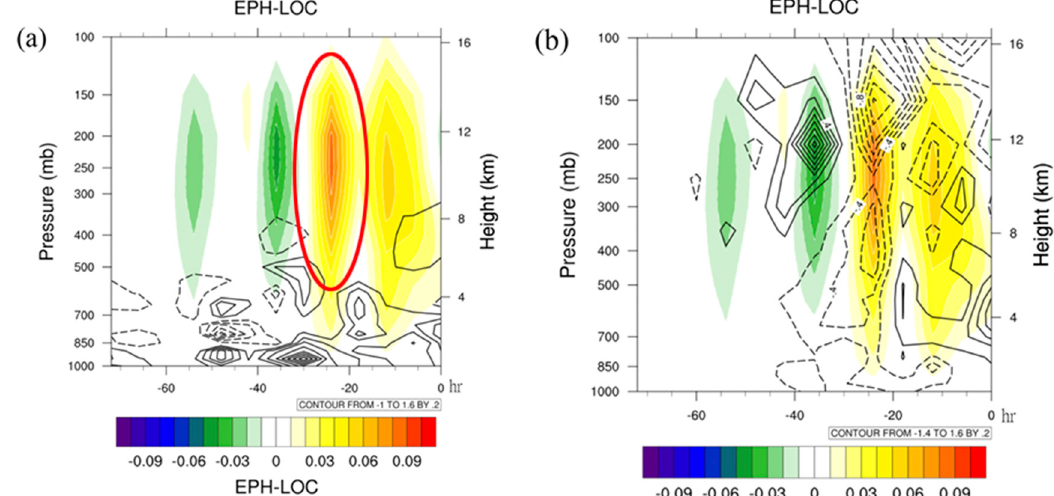
Figure 14. Differences between the excess phase operator (EPH) and local refractivity operator (LOC) experiments in a time–pressure section from − 72 to 0 h for Typhoon Nuri (2008) in ( a ) vertical velocity (colors; m s − 1 ) and water vapor mixing ratio (contours; g kg − 1 ), and ( b ) vertical velocity (colors; m s − 1 ) and vorticity (contours, 10 − 5 s − 1 ) [75].